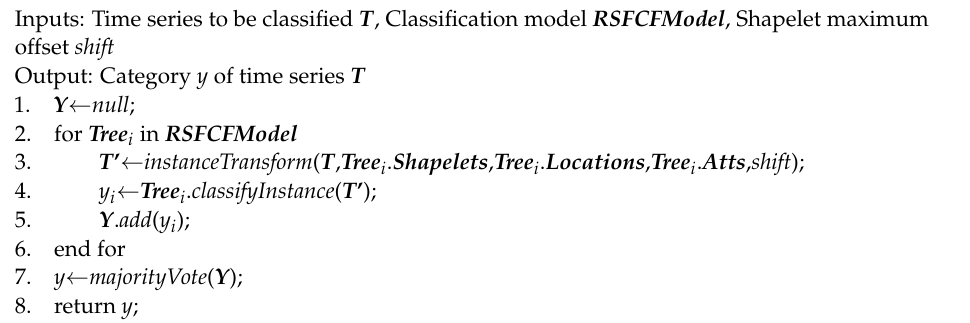
Algorithm 4. classification ( T , RSFCFModel , shift